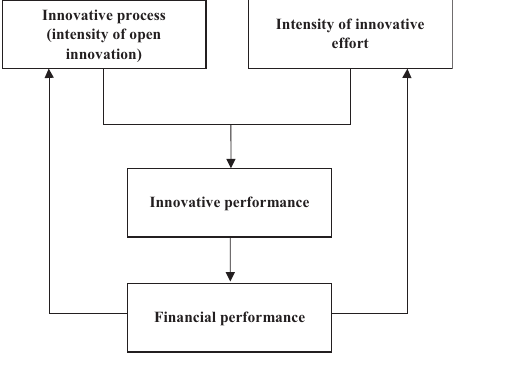
Figure 1. Analytical